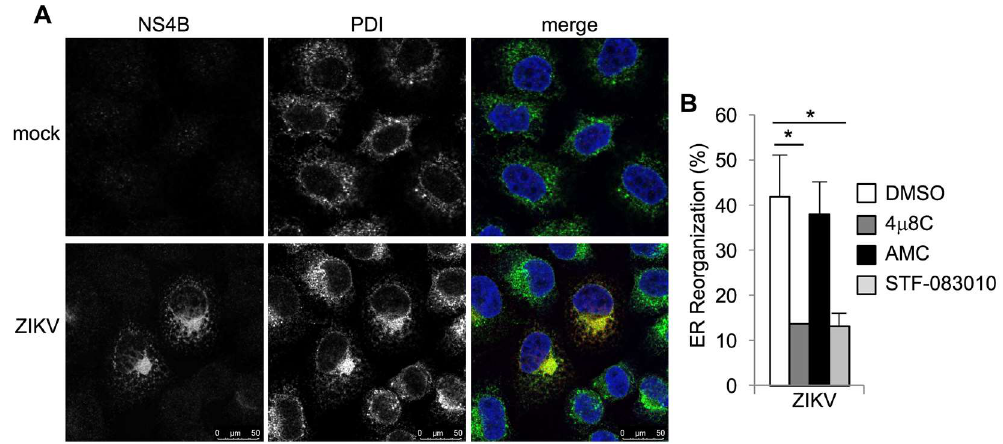
Figure 5. IRE1α inhibitors prevent ZIKV-induced ER reorganization. ( A + B ) Cells were infected with ZIKV for two days. Viral NS4B protein (red in merged image) and the ER marker, protein disulfide isomerase (PDI, green in merged image), were visualized by immunostaining. Nuclei were counterstained with TO-PRO-3 (blue). ( B ) Cells were treated with small molecule inhibitors or DMSO solvent control prior to infection with ZIKV and PDI staining, and ER reorganization was quantified. Data are means ± SD of three independent experiments. * p < 0.05, by unpaired t test.